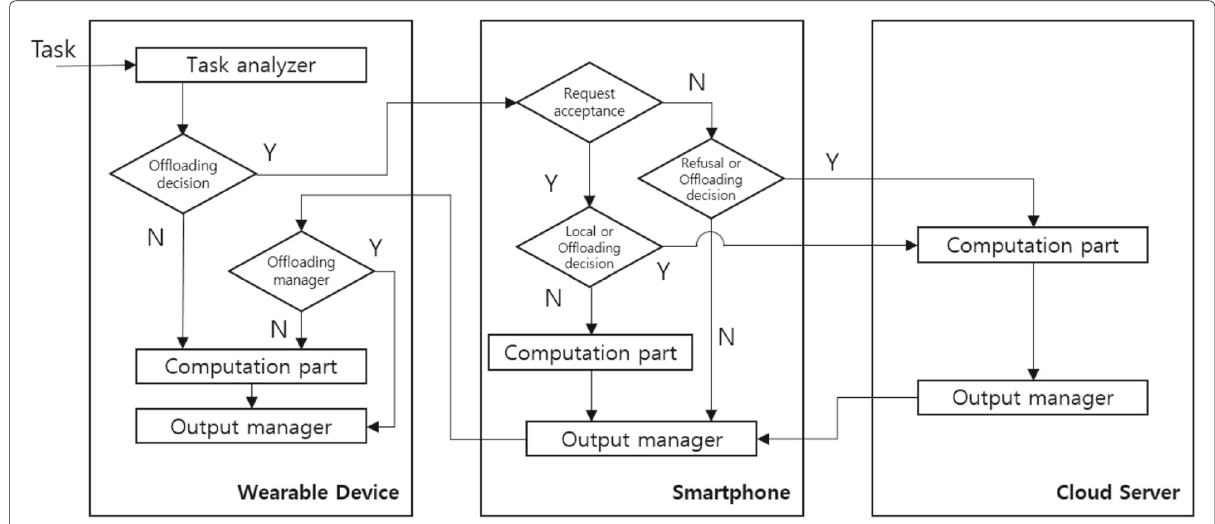
Fig. 1 Workflow chart of the proposed